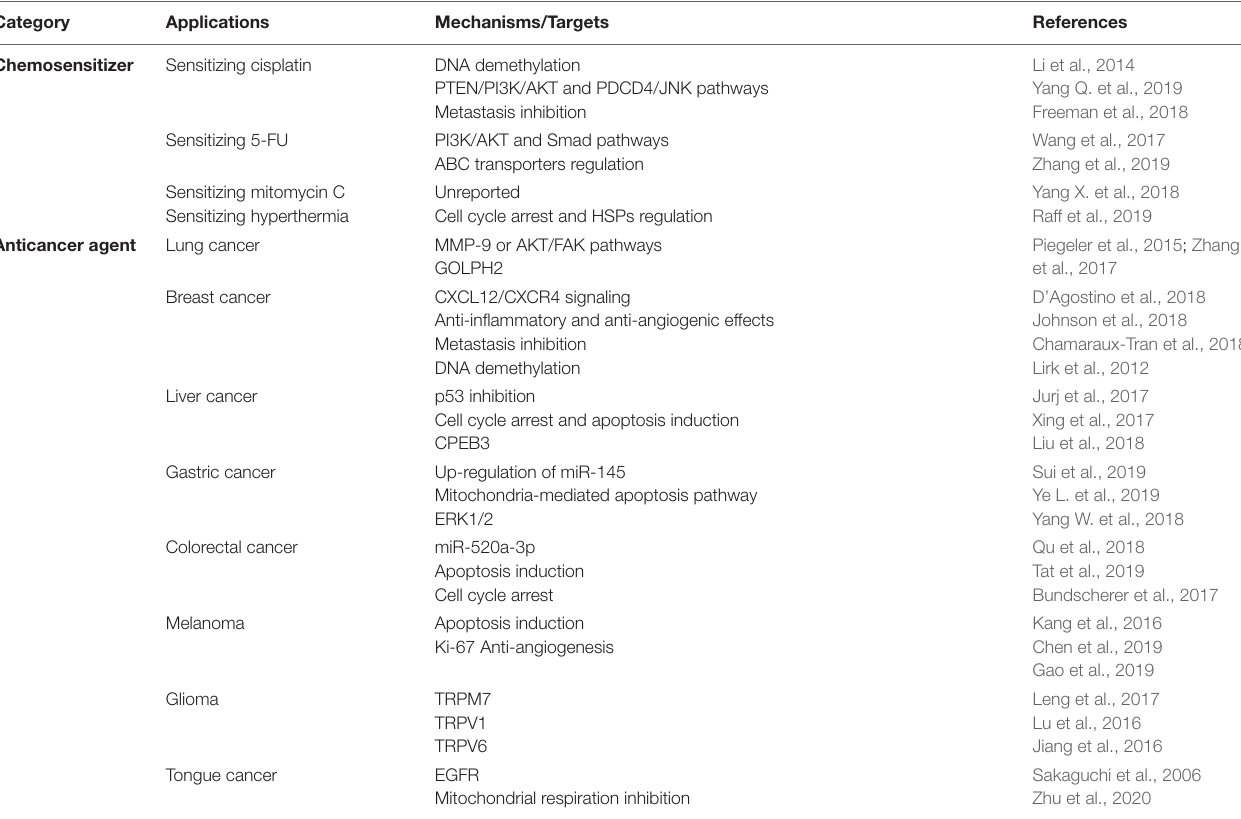
TABLE 1 | Summary of lidocaine in cancer